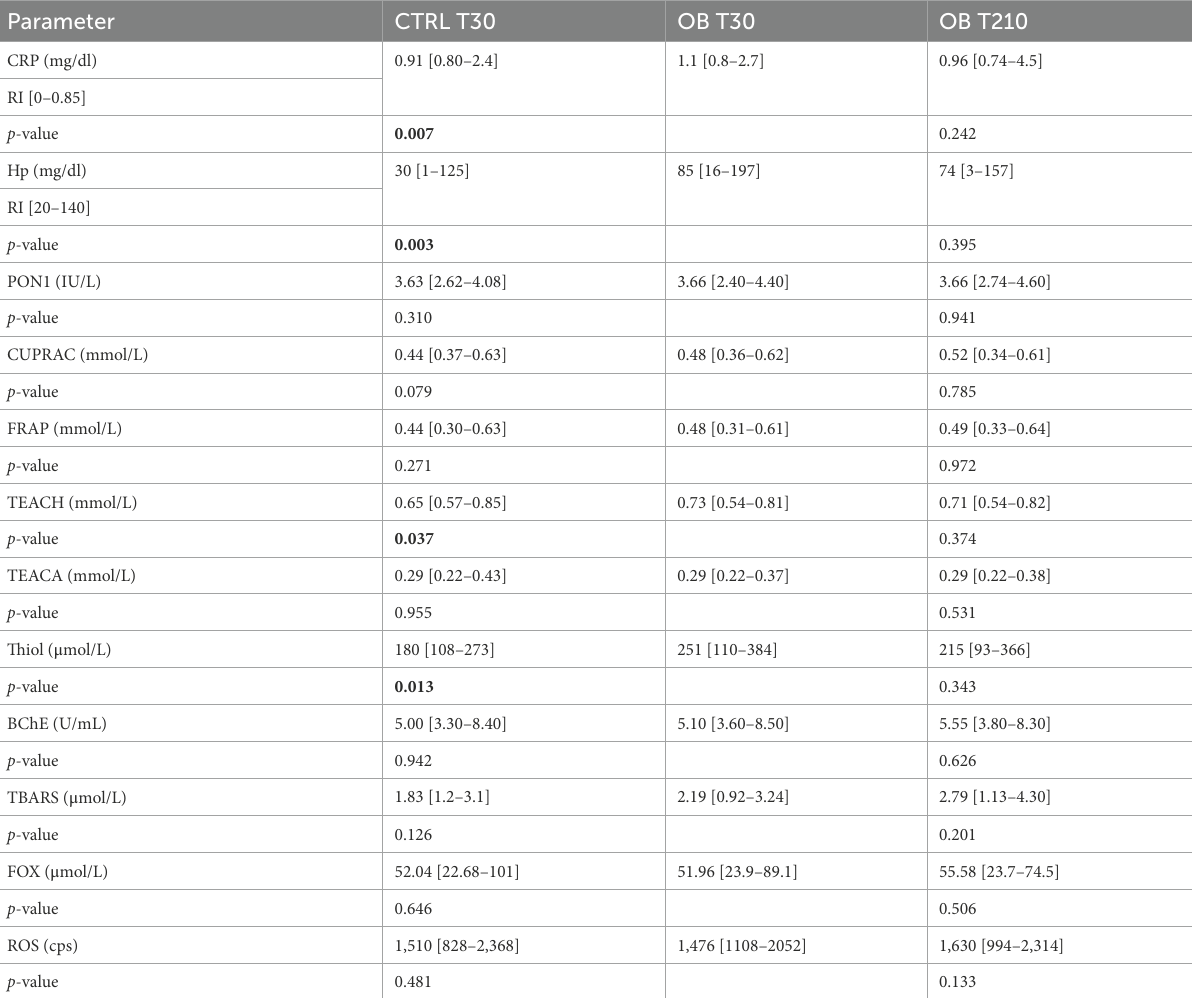
TABLE 4 Serum concentrations of acute phase proteins (CRP and Hp), inflammatory and oxidative stress biomarkers (median [range]) in obese ( n = 16) and lean ( n = 15) dogs fed the same experimental diet, without caloric restriction, for 30 days (phase 1 of the study), and in the same obese dogs after 180 days of caloric restriction (phase 2 of the study).